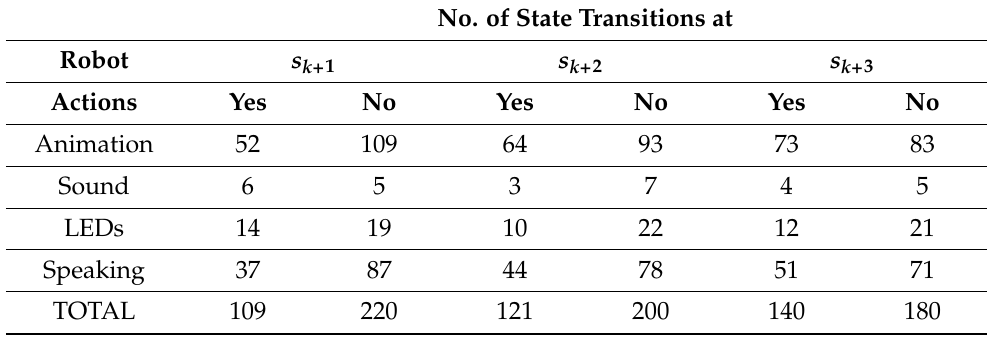
Table 4. Number of “state transitions” for three different definitions of a “state